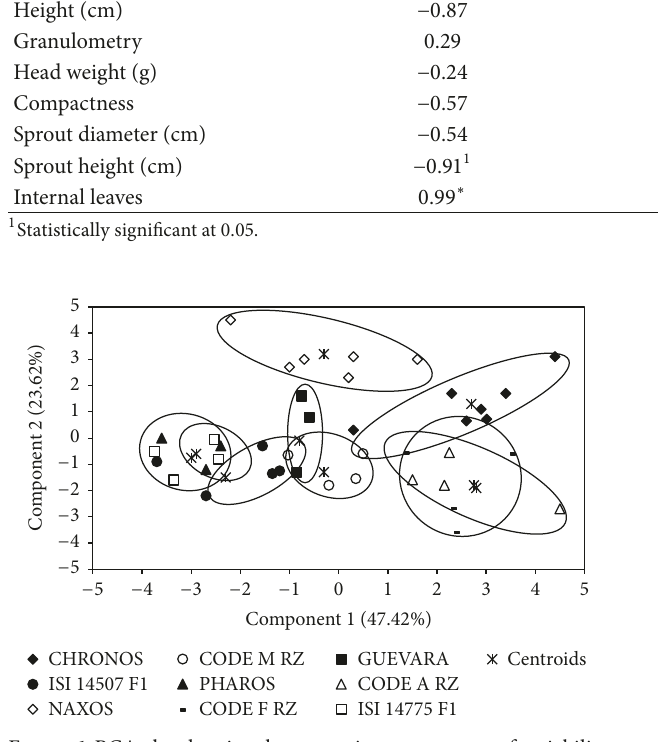
Figure 2: PCA plot showing the two major components of variabil- ity among the broccoli